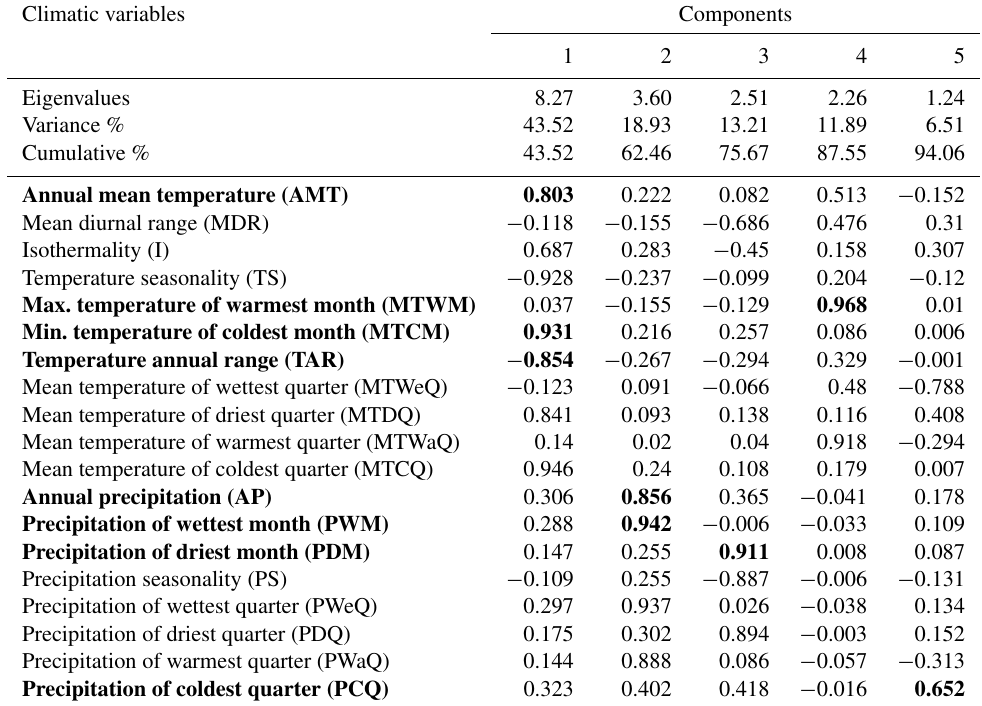
Table 1. Factor analysis showing the eigenvalues, variance percentages, cumulative percentages and correlations of 19 climatic variables with the five components. Climatic variables in bold were selected for further